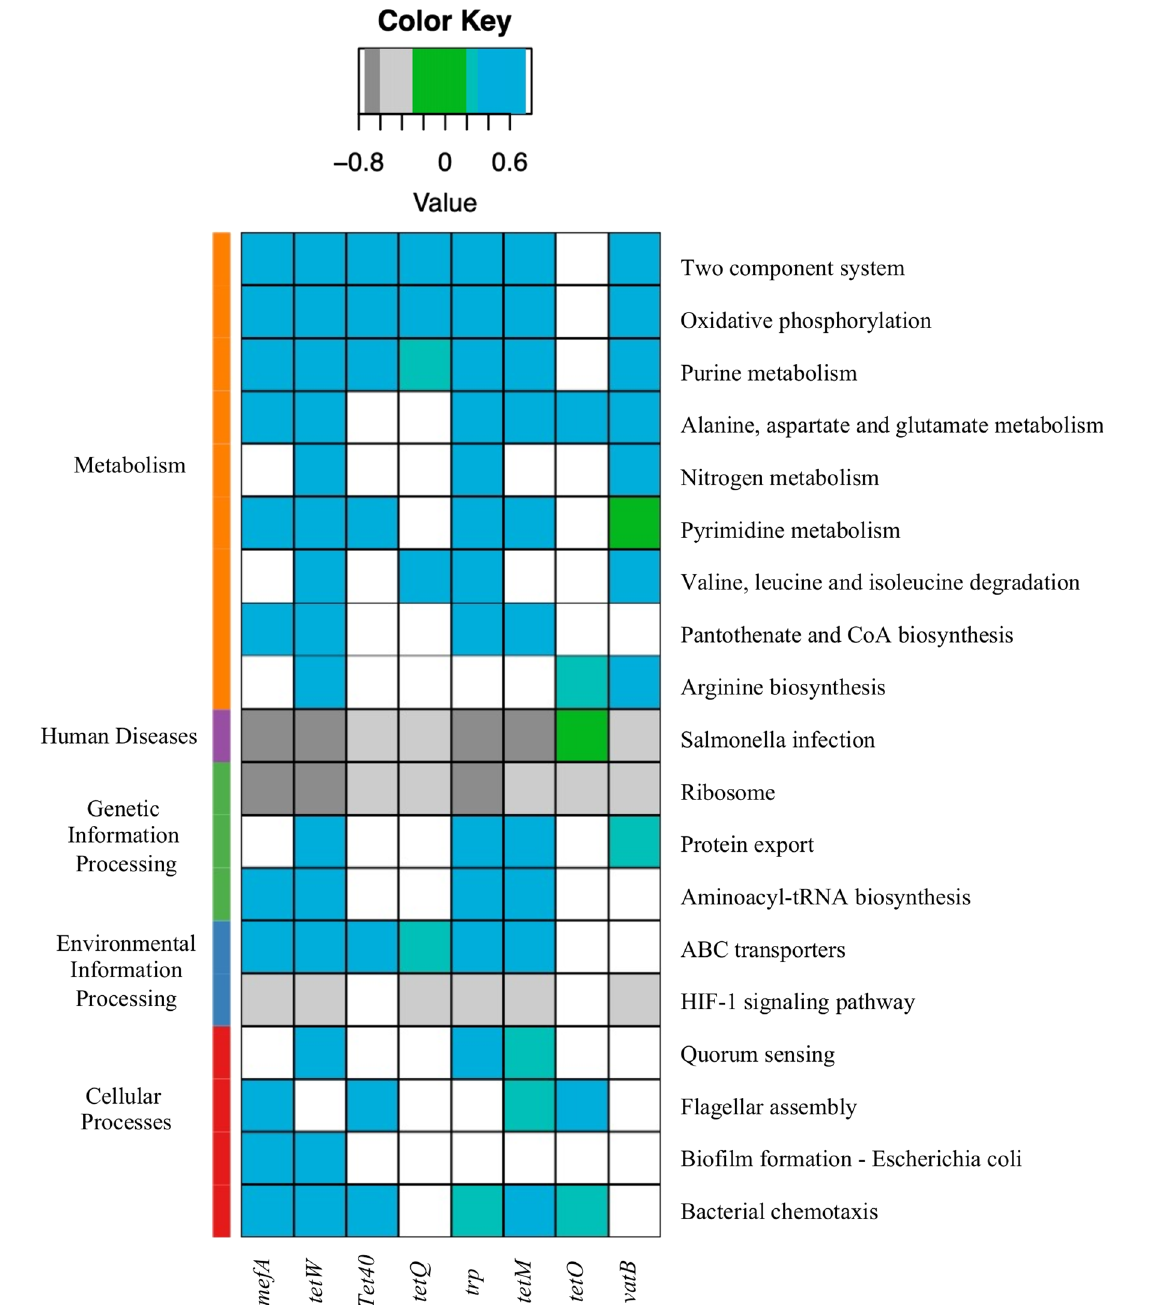
Fig. 6 Heatmap showing the Spearman correlations between the abundance (normalized into reads per million) of KEGG pathways and the abundance of 8 subtypes of expressed ARGs. ARG, antimicrobial resistant gene; trp , tetracycline resistance